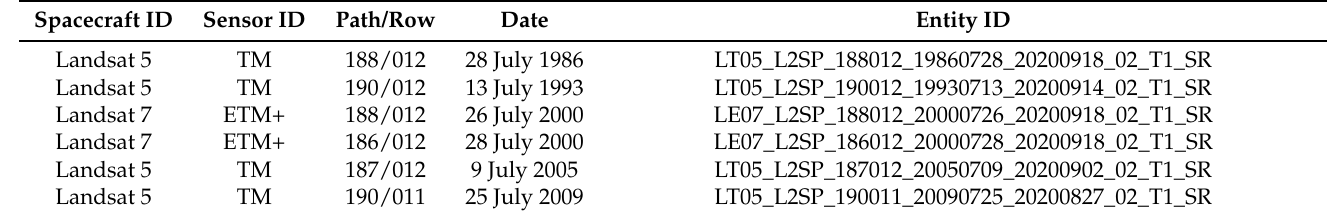
Table 2. Downloaded Landsat product entities used for collecting training and testing data for the classifier.